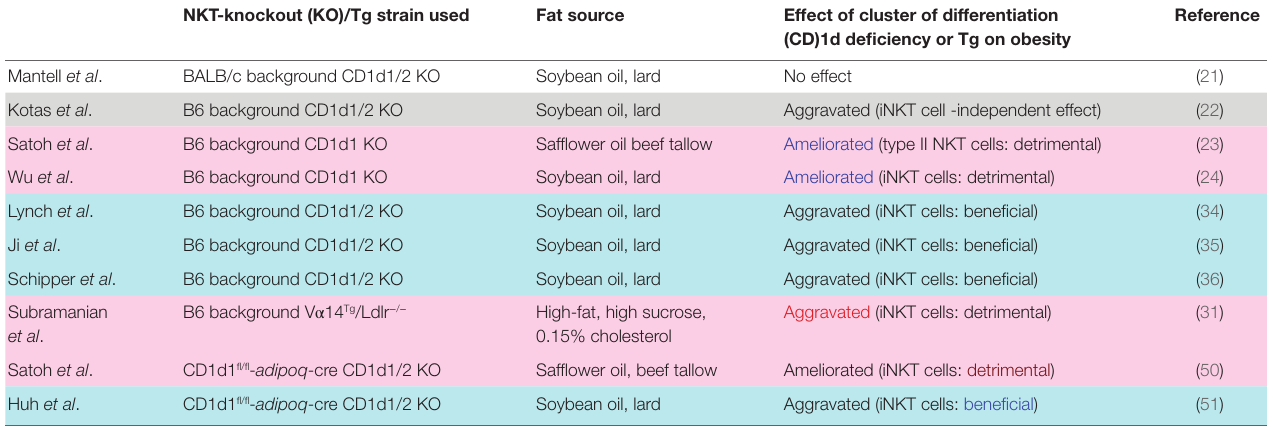
TABLe 1 | Roles of natural killer T (NKT) cells in the development of diet-induced obesity. nKT-knockout (KO)/Tg strain used Fat source effect of cluster of differentiation (CD)1d deficiency or Tg on